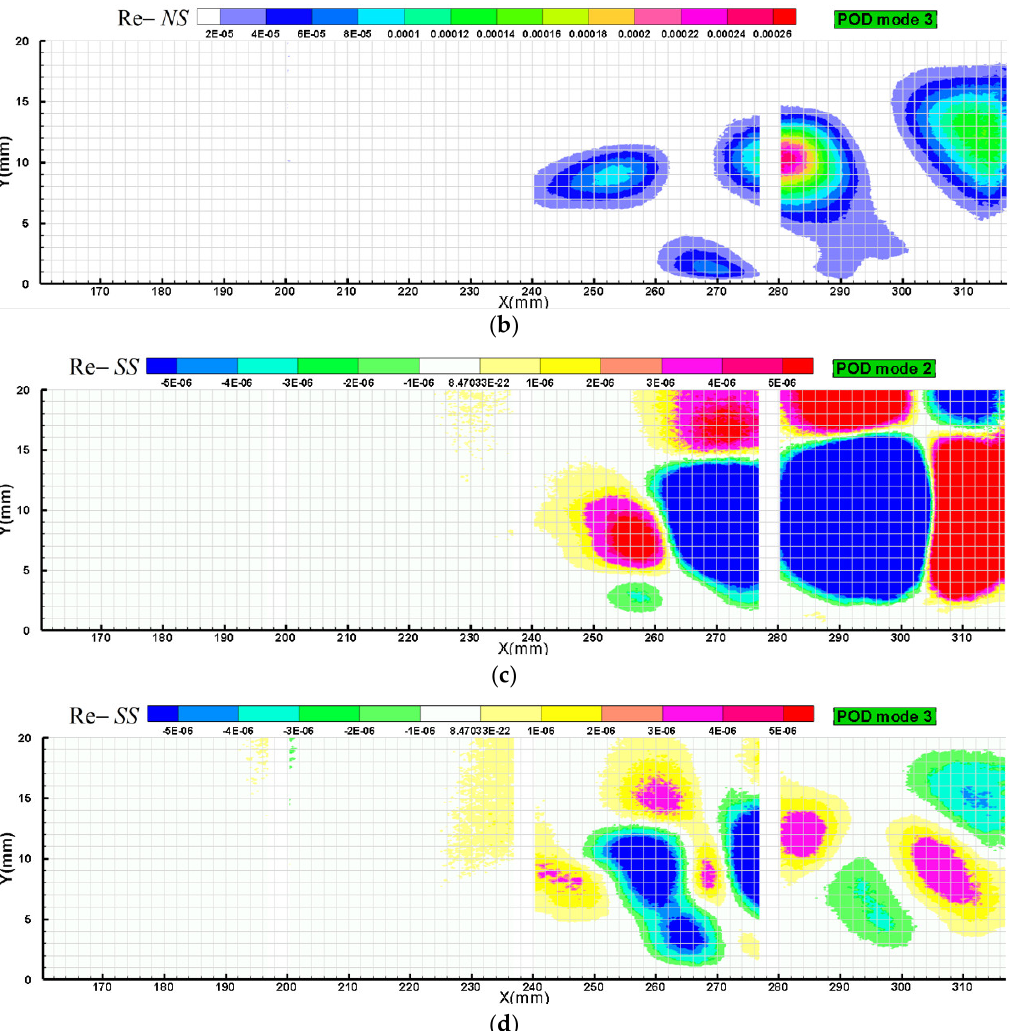
Figure 10. ( a ) The second-order mode of the Reynolds normal stress; ( b ) the third-order mode of the Reynolds normal stress; ( c ) the second-order mode of the Reynolds sheer stress; and ( d ) the third-order mode of the Reynolds sheer stress.